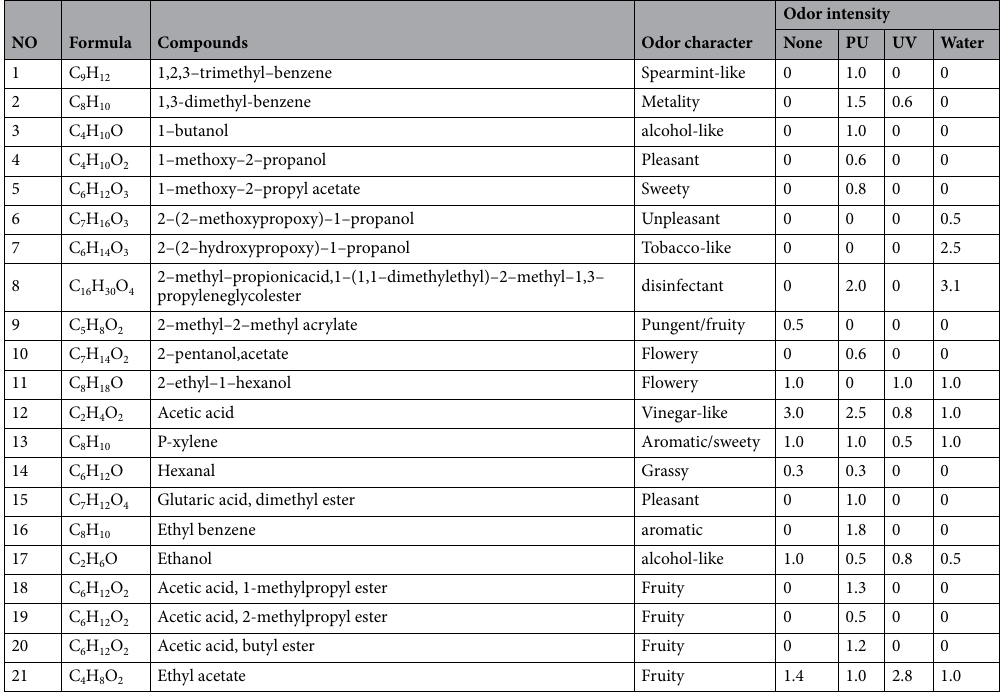
Table 4. Identification of odor–active compounds of Xylosma racemosum (Sieb. et Zucc.) Miq. with different lacquer.